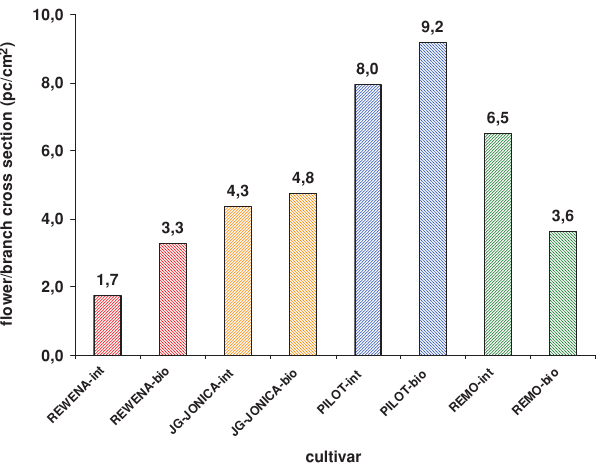
Figure 1. The number of inflorescences per cross section area of four apple varieties grown according to different growing technologies ( Debrecen- Pallag, 2010)